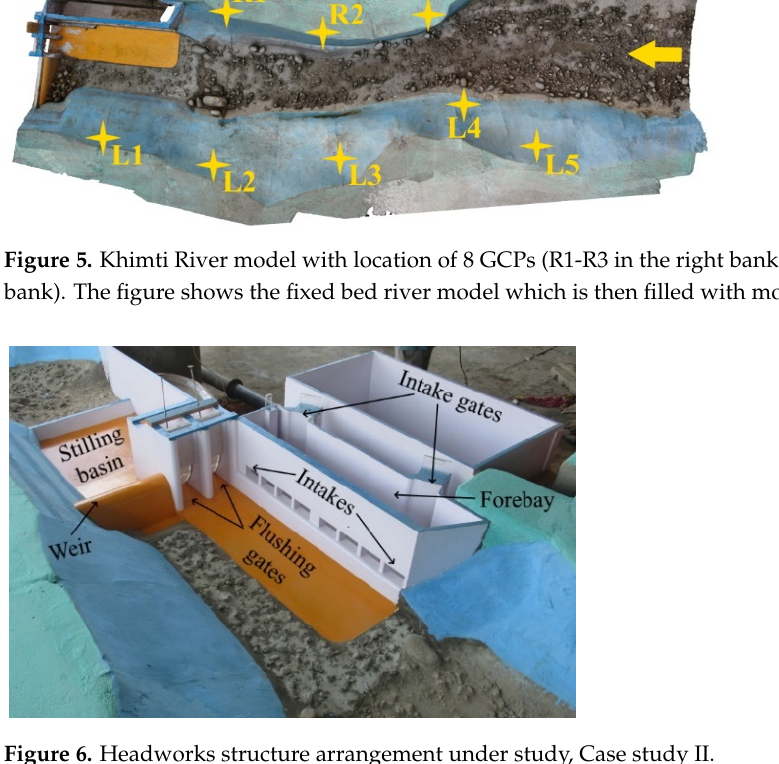
Figure 6. Headworks structure arrangement under study, Case study II. In order to speed up the sedimentation process, the river upstream of the weir was initially filled with bed sediment up to the sill level of intake orifices. The sand used for representing the bed load had median particle diameter ( d 50 ) of 1.5 mm, d 10 = 0.5 mm and d 90 = 10 mm. The sediment fed with the inflow discharge during the test also had the same composition. The model was run under normal operating conditions for 12 min (1.3 h in prototype) simulating a river discharge of 14.4 L/s (equivalent to annual flood with the magnitude of 146 m 3 /s in prototype) with sediment feeding at the rate of 0.580 kg/min which corresponds to sediment concentration of 671 ppm in the flow. Then both flushing gates were opened to allow free gravity flushing of the bed sediment with the annual flood discharge for 38 min (4 h in prototype). Initial bed before flushing and final bed